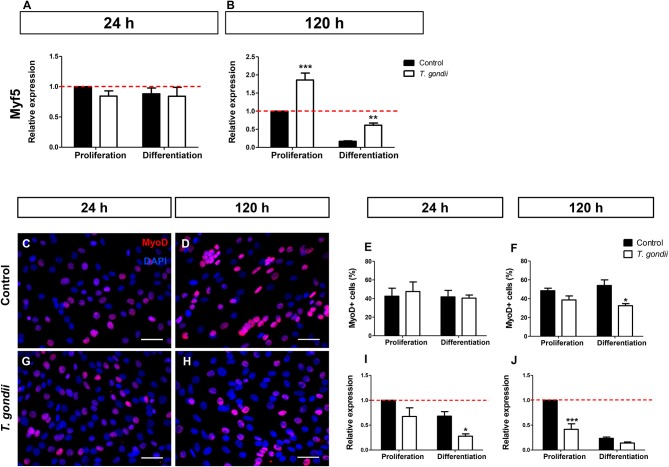
Infection affects early myogenic gene expression. Relative expression of Myf5 was analyzed by RT-qPCR. Myf5 levels were determined at the initial time of myogenesis (24 h, A) and at the latest time point (120 h, B). Uninfected and infected cells in PM or DM were immunostained for MyoD (red) and DAPI (blue) at 24 (C,G) and 120 h of induction (D,H). Quantification of MyoD-positive cells at 24 h indicate that infection led to no significant changes in the number of MyoD cells (E). After 120 h of myogenic stimulation, infected-DM cultures displayed 32% of MyoD-positive cells, whereas in uninfected DM dishes a 54% rate was observed (F). RT-qPCR revealed that at 24 h of induction, MyoD transcript was significantly less abundant in infected-DM dishes, when compared to the controls (I). During late stage myogenesis (120 h), T. gondii-infected cells in PM presented a 59% decrease in MyoD expression when compared to controls (J). Results of at least three independent experiments *p < 0.05, **p < 0.01; ***p < 0.0001, Two-Way ANOVA with Bonferroni post-test. The red dotted line represents the value of control uninfected cultures maintained in the Proliferation Medium. Scale bar = 50 μm.